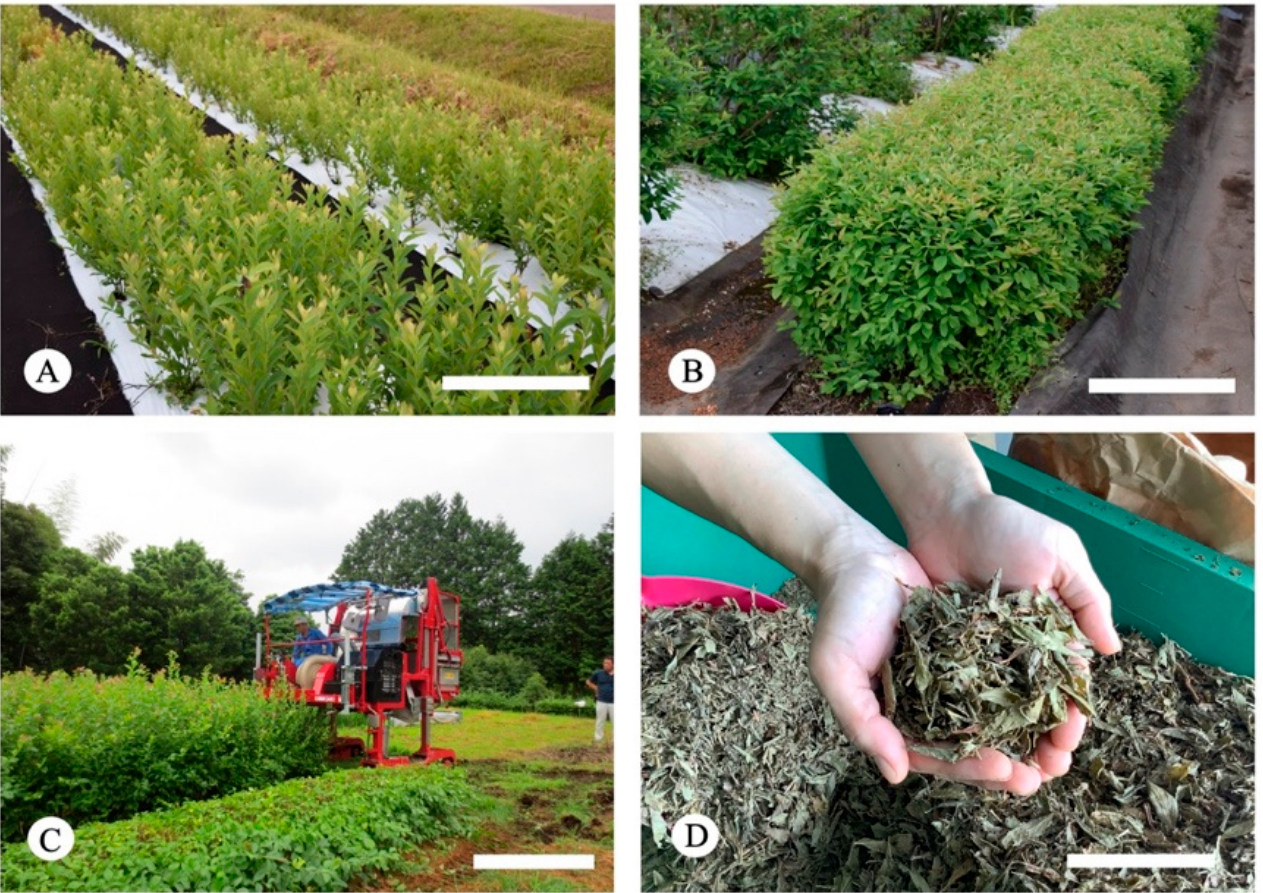
Figure 1. Mass production of leaves and teamaking from rabbiteye blueberry ‘Kunisato 35 Gou’. ( A ) Dense planting of cutting nursery. Bar = 50 cm. ( B ) Leaf production method similar to Japanese green tea cultivation. Bar = 50 cm. ( C ) Mechanical harvesting. Bar = 100 cm. ( D ) Dried tea leaves. Bar = 10 cm.